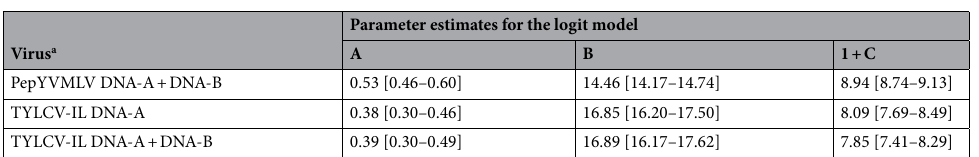
Table 2. Estimated parameters [95% confidence intervals] of the logistic growth model of the progression of disease symptom severity in tomato plants agroinoculated with PepYVMLV and TYLCV-IL DNA-A in single or mixed inoculation with PepYVMLV DNA-B. A: Slope of the linear phase at the inflection point of the logistic disease progression curve. B: Time to reach 50% of the symptom severity at the plateau phase. 1 + C: Maximum symptom severity at the final plateau. a For PepYVMLV DNA-A alone, symptom severity does not show a logistic progress curve (see Fig. 2a); thus, parameters A, B and C cannot be calculated in this